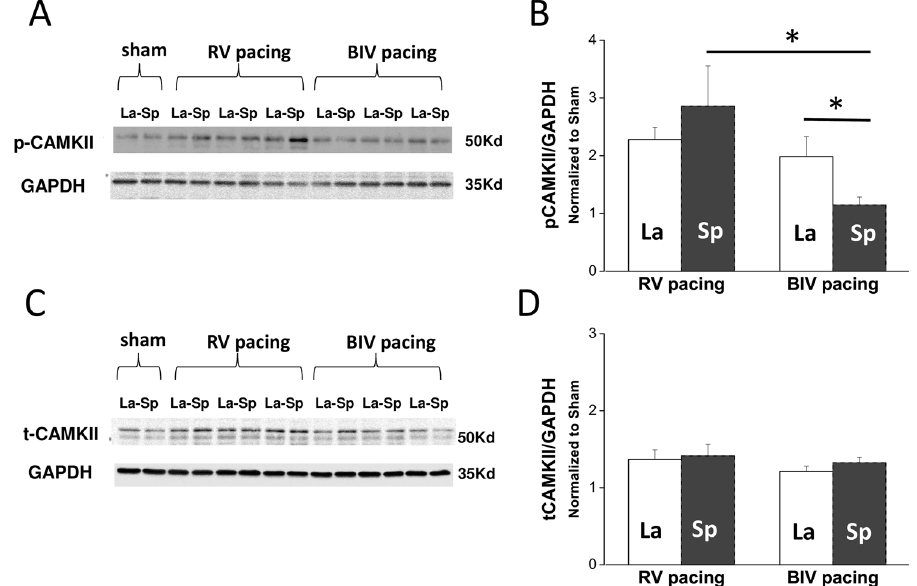
Figure 5. RV tachypacing induces global activation of CAMKII. Biochemical analysis of CAMKII in rats subjected to either RV tachypacing or BiV tachypacing at a CL of 100 ms for 72 hours. La = lateral wall, Sp = septum. ( A ) An immunoblot demonstrating phospho-CAMKII (p-CAMKII) levels and GAPDH (loading control). Cropped blots are shown. Uncropped blots are presented in Supplementary Fig. 5S. ( B ) Bar graph summarizing the p-CAMKII densitometry results of each pacing mode. Note the marked increase of p-CAMKII in both septum and lateral wall of rats exposed to RV tachypacing. In comparison with the RV- paced rats, BiV-paced rats demonstrated reduced p-CAMKII levels mainly in the septum. ( C ) Immunoblot for total CAMKII. Cropped blots are shown. Uncropped blots are presented in Supplementary Fig. 5S. ( D ) Bar graph summarizing the CAMKII densitometry results at each pacing mode.